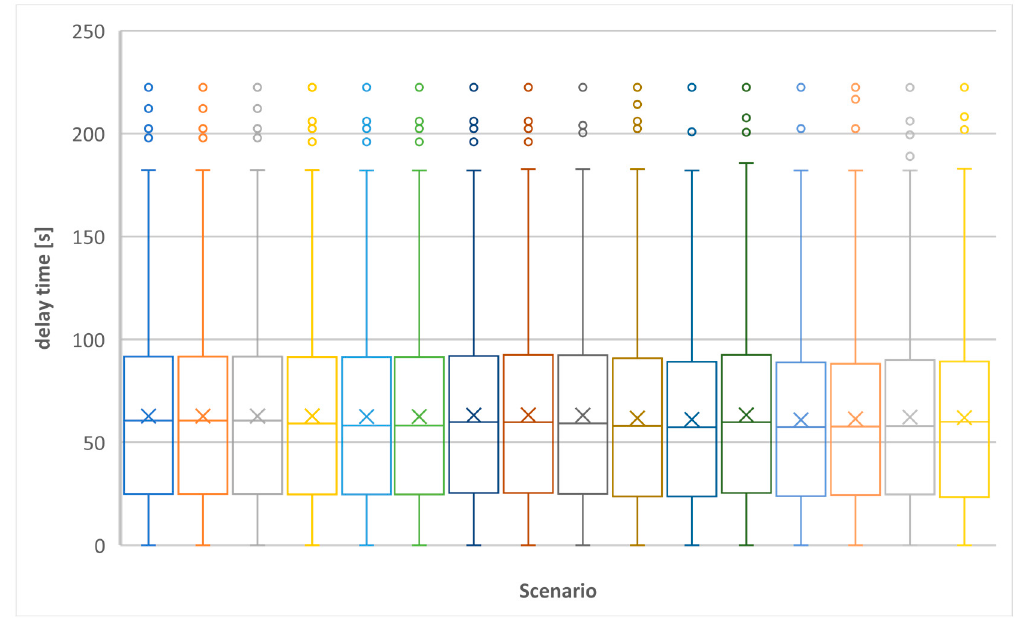
Figure 8. Positional measures and the average (x) difference between optimal driving times for the total number of vehicles on the network in each simulation scenario.